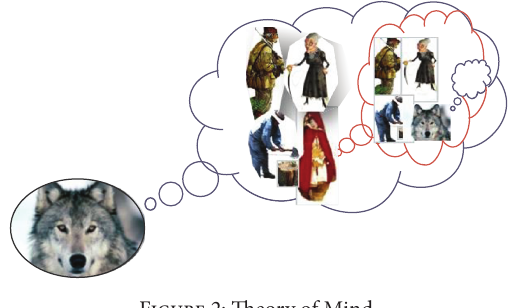
Figure 2: Theory of